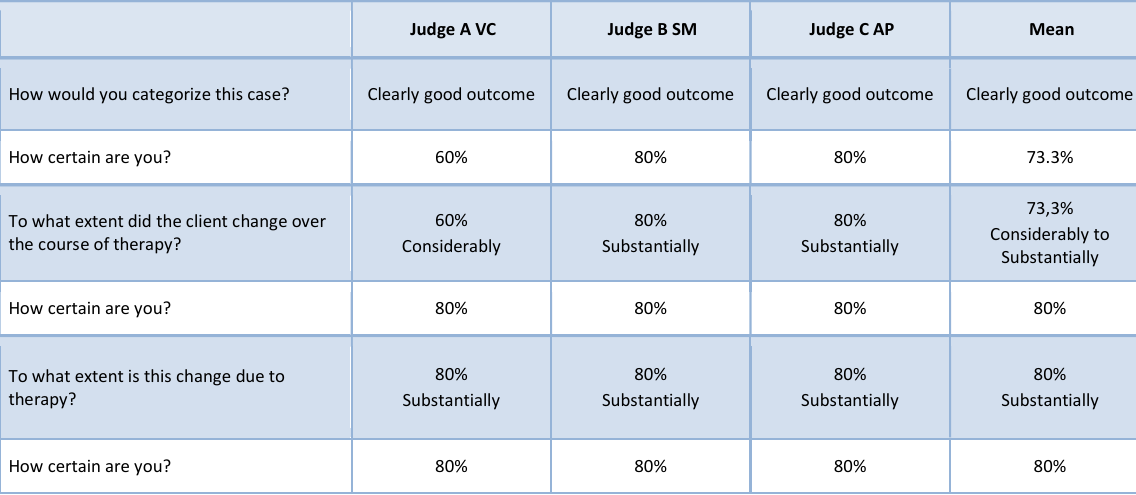
Table 5: Adjudication